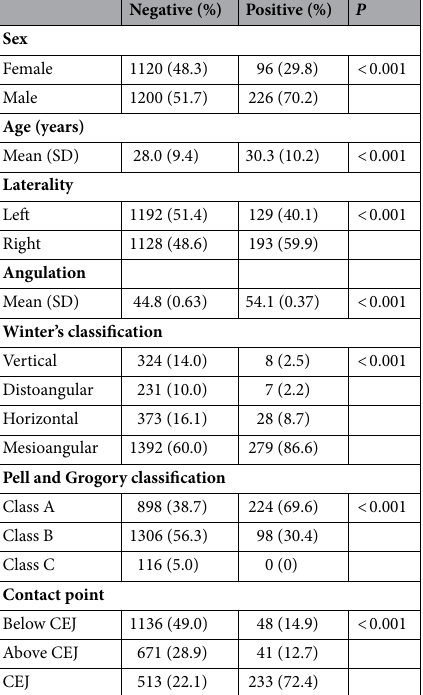
Table 1. Characteristics of negative (n = 2320) and positive (n = 322) DCM2Ms. The circular mean and circular standard deviation were used for the analysis of angulation. DCM2M distal caries in mandibular second molars, CEJ cementoenamel junction, SD standard